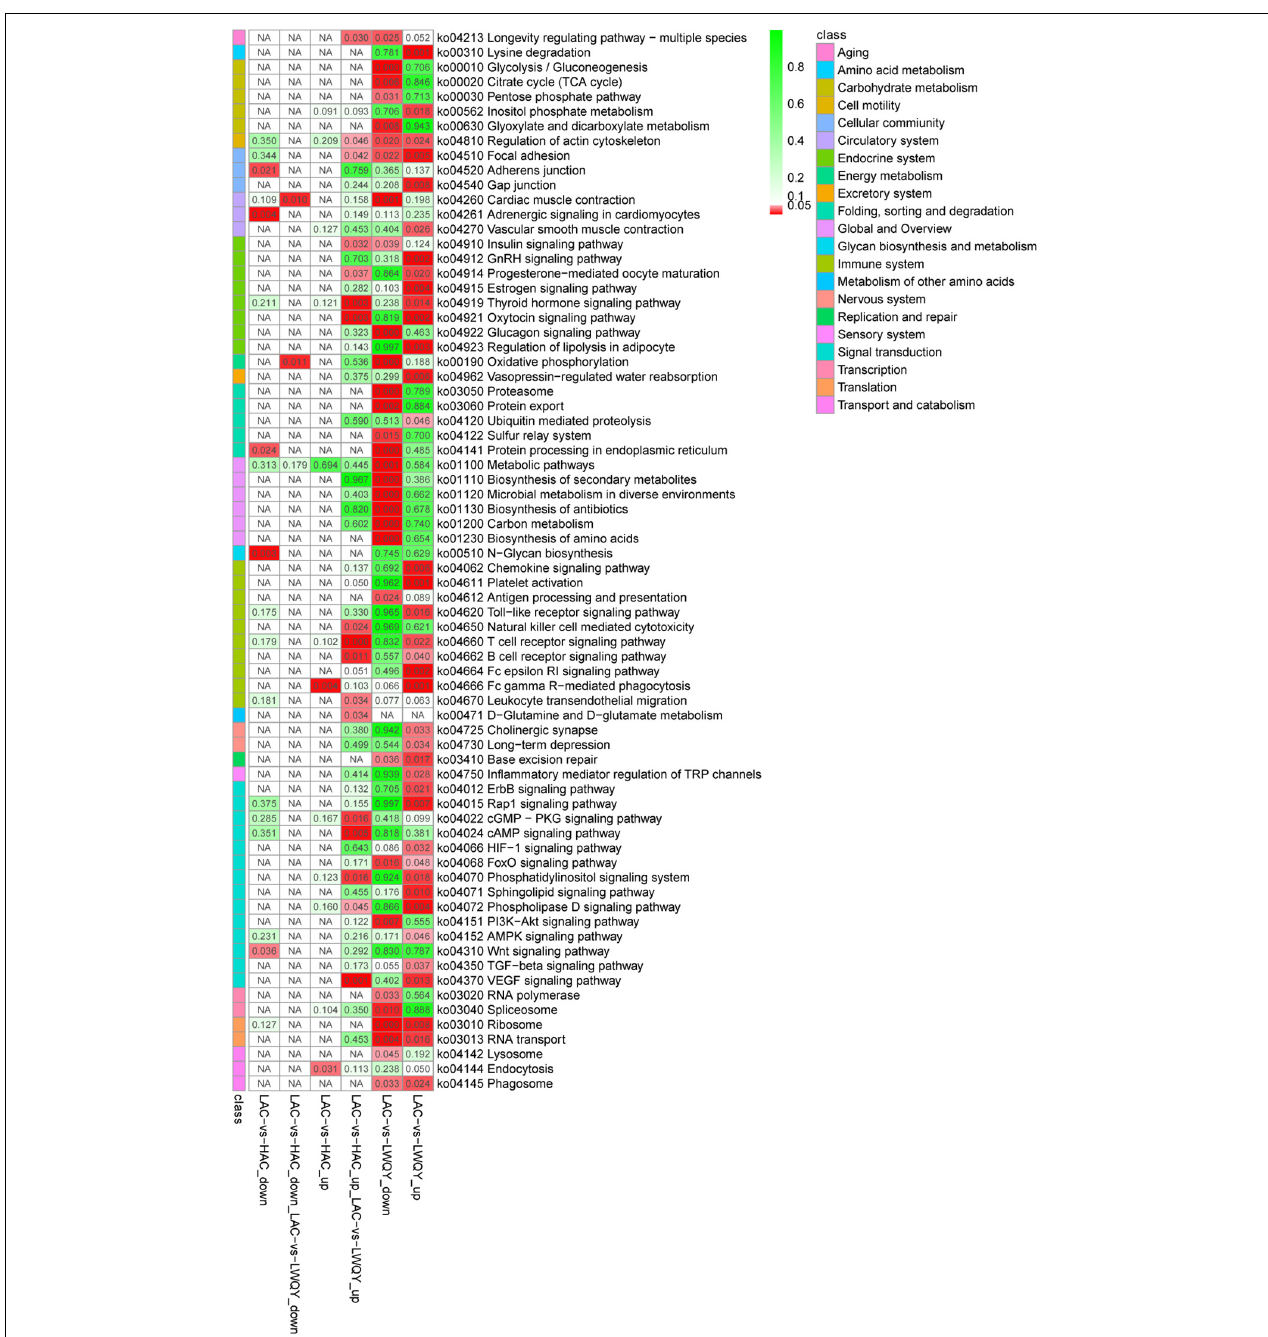
FIGURE 2 | Kyoto Encyclopedia of Genes and Genomes pathway assignments for the 178 differentially co-expressed protein-coding transcripts between the LAC-vs-LWQY and LAC-vs-HAC comparison groups. “KEGG” is short for “Kyoto Encyclopedia of Genes and Genomes.”